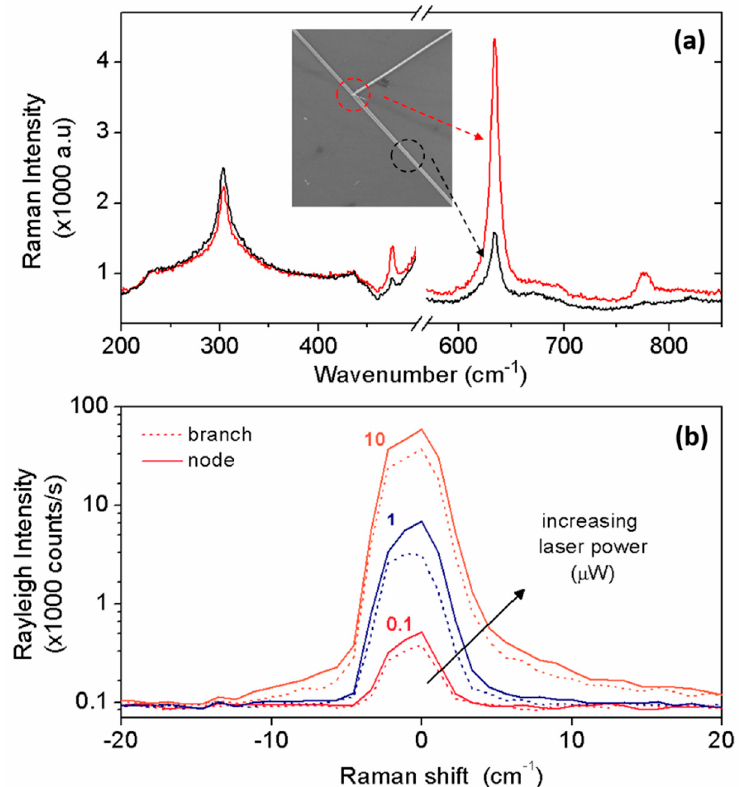
Figure 4. ( a ) Raman spectra measured at different locations (node and branch) of a T-branched SnO 2 NW, as shown in the SEM image. ( b ) Rayleigh spectra measured at node (solid line) and arm (dashed line) locations for different and increasing incident laser power (0.1, 1 and 10 μ W).